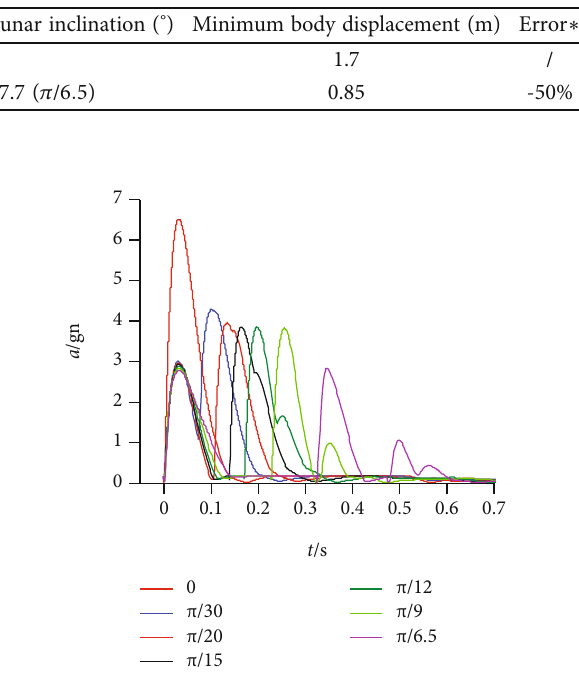
Figure 20: Body overload vs. time.